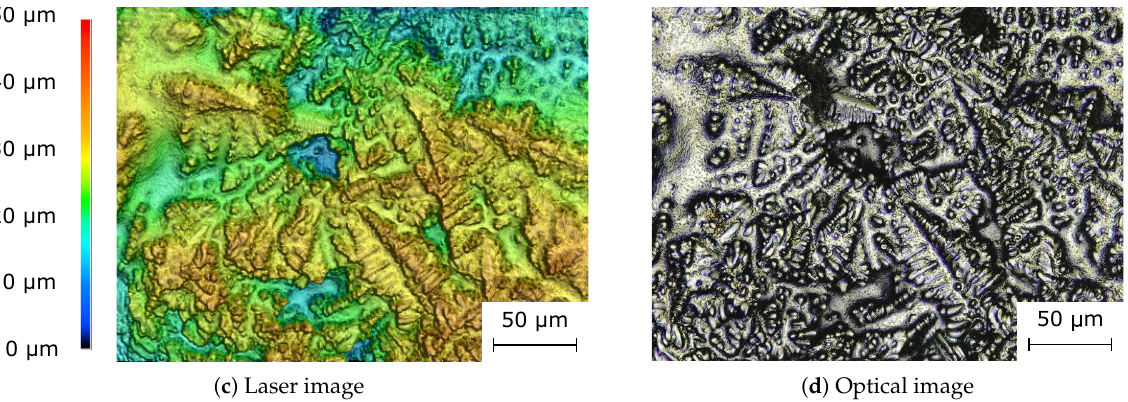
Figure 13. Surface of the SA-sample analyzed with the confocal laser scanning microscope. The top images show the sample’s surface before coming into contact with molten salt and the bottom two images show the surface after molten salt contact. Next to the laser images ( a , c ), the corresponding optical images are displayed ( b , d ). No significant change in the surface can be seen. The results of the confocal laser scanning microscopy for the other two droplets do not differ